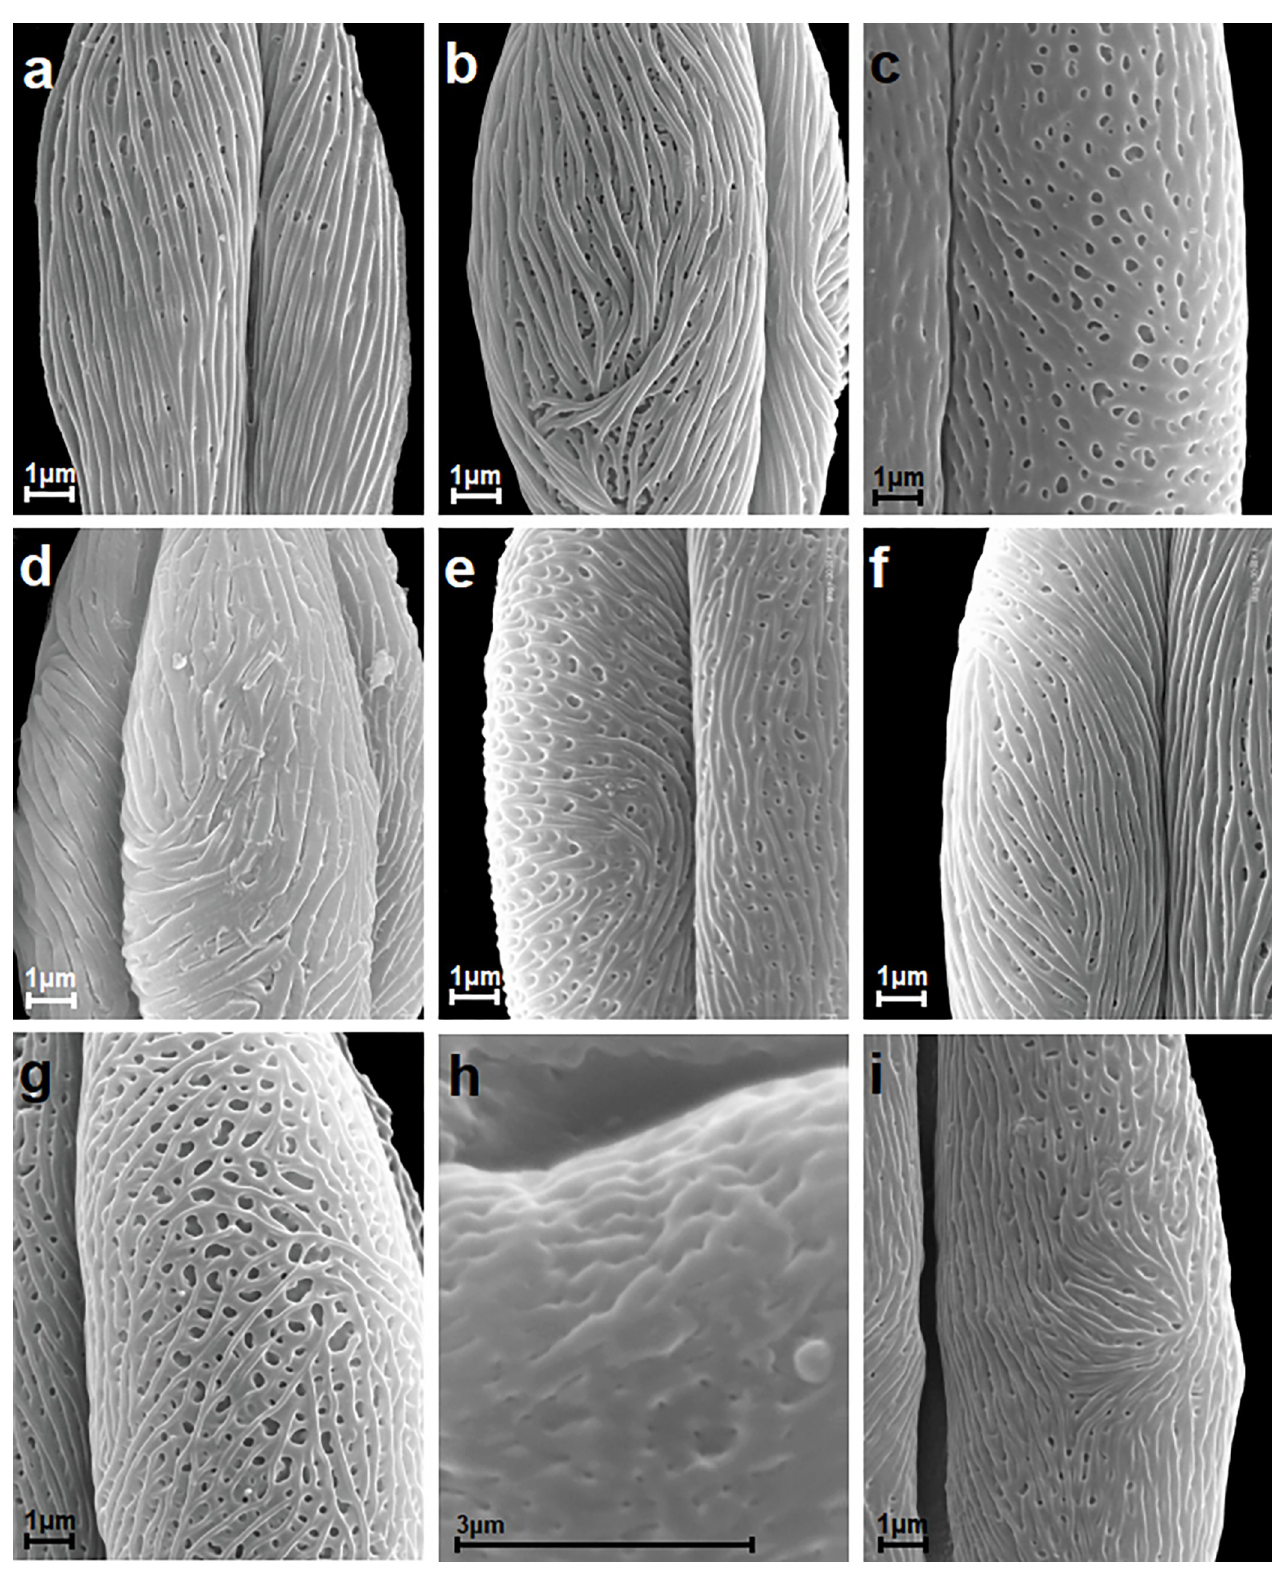
Fig 5. Striate exine ornamentation types according to Ueda and Tomita [63]; see Table 6. A-I. A, S . media ; B, S . pubescens ; C, S . salicifolia ; D, S . splendens ; E, S . thunbergii ; F, S . trichocarpa ; G, S . uratensis ; H, S . veitchii ; I, S . tomentosa . https://doi.org/10.1371/journal.pone.0273743.g005 PLOS ONE | https://doi.org/10.1371/journal.pone.0273743 August 29,